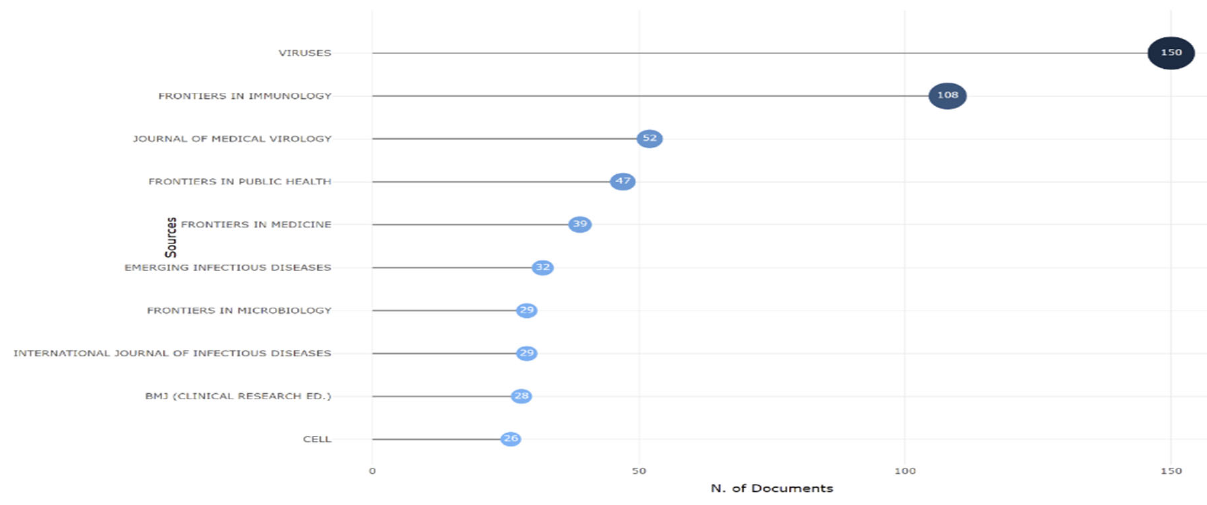
Figure 3. Top ten most productive journals.